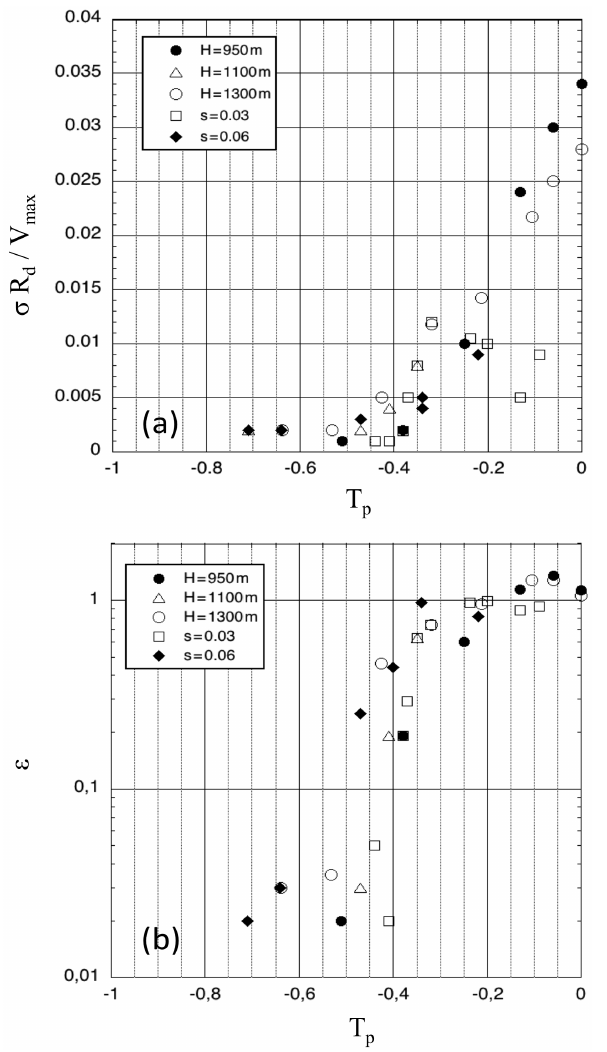
Figure 3. (a) Dimensionless growth rates σ m R d /V max and (b) the non-linear saturation parameter ε as a function of the topographic parameter T p for the same coastal current ( Ro = 0 . 25) above var- ious shelves. We consider here a large range of bottom slopes ( s = 0–6%) and water depths ( H = 600–5000m).